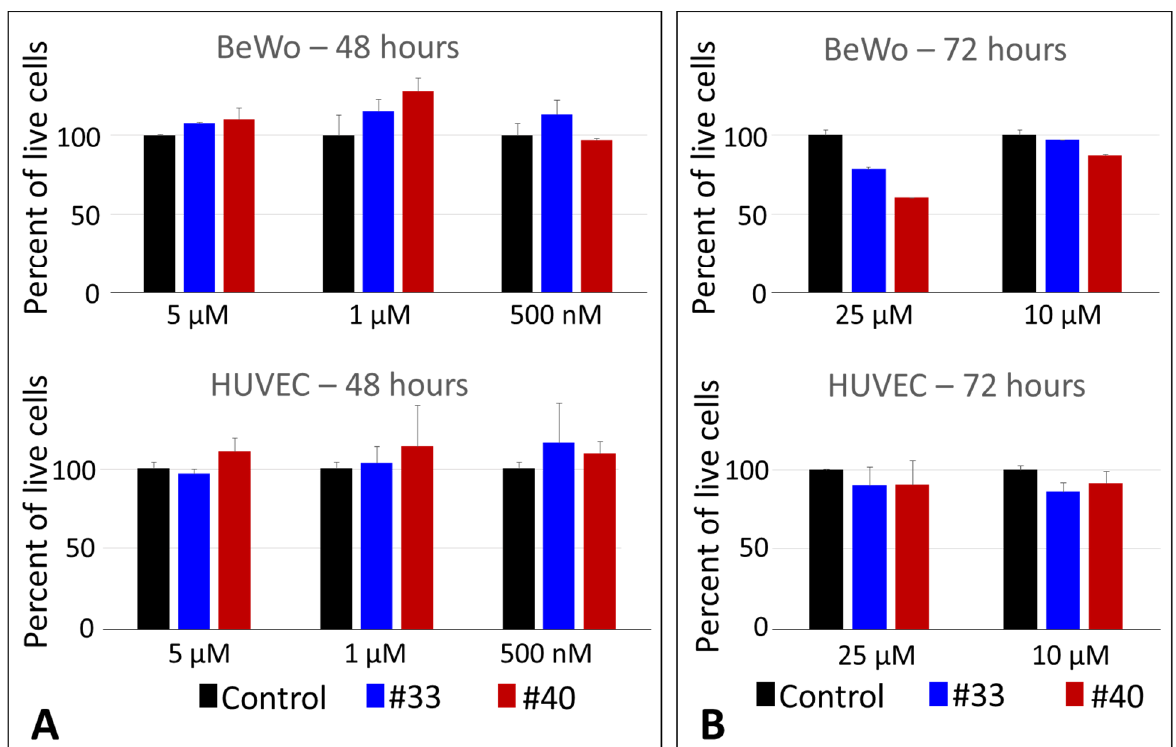
Figure 8. In vitro cellular toxicity of individual compounds #40 and #33 by crystal-violet cell viability assay: ( A ) 48-h assay and ( B ) 72-h assay. Columns represent averages and error bars are SD of duplicate measurements. Data are representative of two independent experiments.